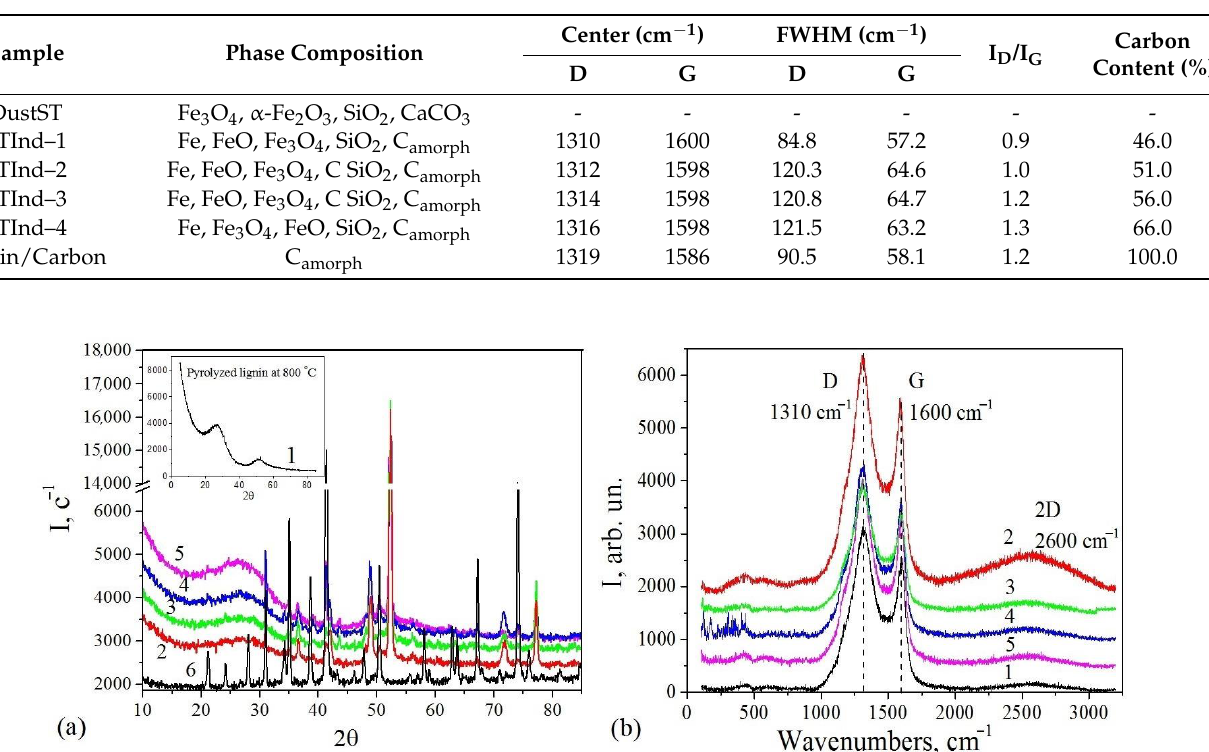
Table 4. Structural characteristics of biochars.